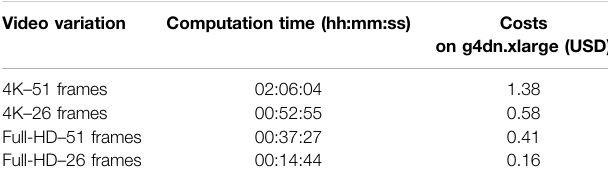
TABLE 1 | Computation time and costs of the 3D reconstruction. Video